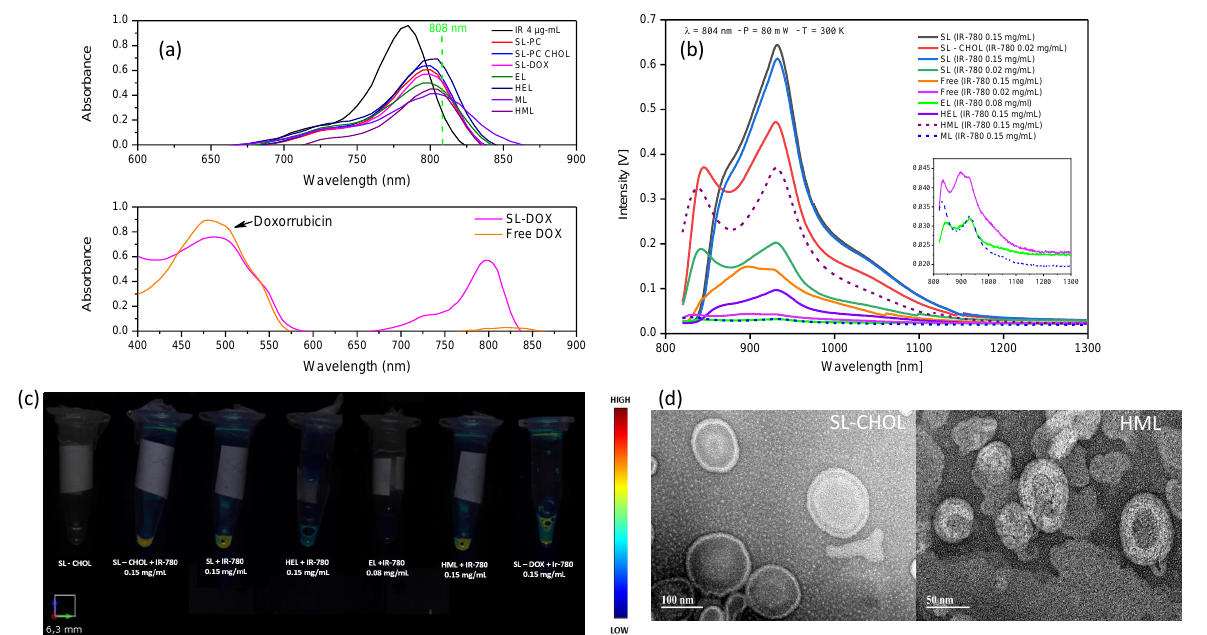
Figure 2. Photophysical and morphological properties of the nanoparticles: ( a ) UV-VIS-NIR absorp- tion spectra of free IR-780, free DOX, SLs, SL-CHOL, ELs, MLs, HELs and HMLs; ( b ) fluorescence spectra of free IR-780, SLs, SL-CHOL, ELs, MLs, HELs and HMLs after excitation at 804 nm. Samples with different amounts of IR-780 are shown. The inset shows the spectra of free IR-780 0.02 mg/mL, ELs and MLs, confirming the band at around 850 nm; ( c ) fluorescence molecular tomography images of SL-CHOL without IR-780 (control sample), SLs, SL-CHOL, ELs, HELs, HMLs and SL-CHOL with DOX. ( d ) TEM images of SL-CHOL and